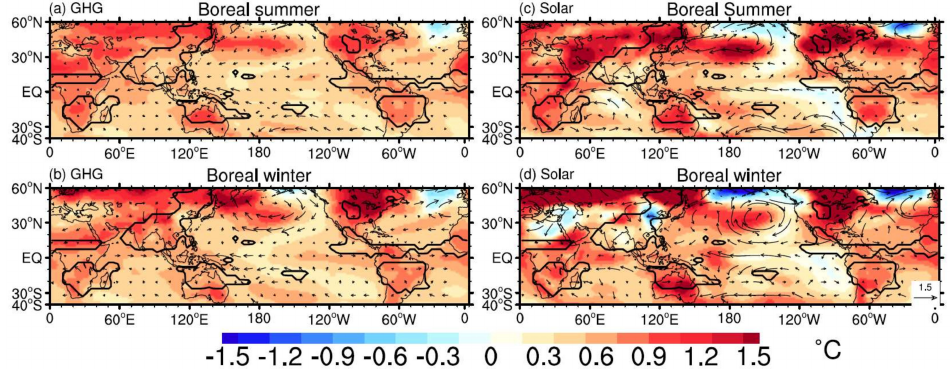
Figure 7. Horizontal distribution of temperature change. Shown are the spatial patterns of the change of surface temperature (shading) and the change of 850-hPa wind (vector) in boreal summer ( a , c ) and boreal winter ( b , d ) under the GHG ( a , b ) or solar ( c , d ) forcing between PWP and LIA. Each field is scaled to have the same global-mean temperature anomaly (PWP minus LIA) as the full forcing. Most of the temperature changes are significant; thus, we do not show the significance test.